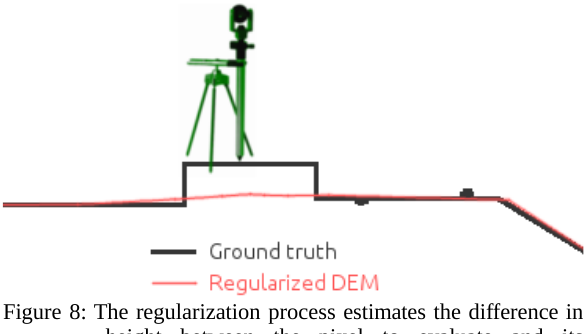
Figure 8: The regularization process estimates the difference in height between the pixel to evaluate and its neighbors. It usually smooths the blades of grass, tiny holes, but can also misevaluate a check points altitude. Table 3: Dataset 2015, the 1100 meter long acquisition is calculated using different camera model. The results after compensation on 11 GCP confirms that an improper camera model is not efficiently corrected.